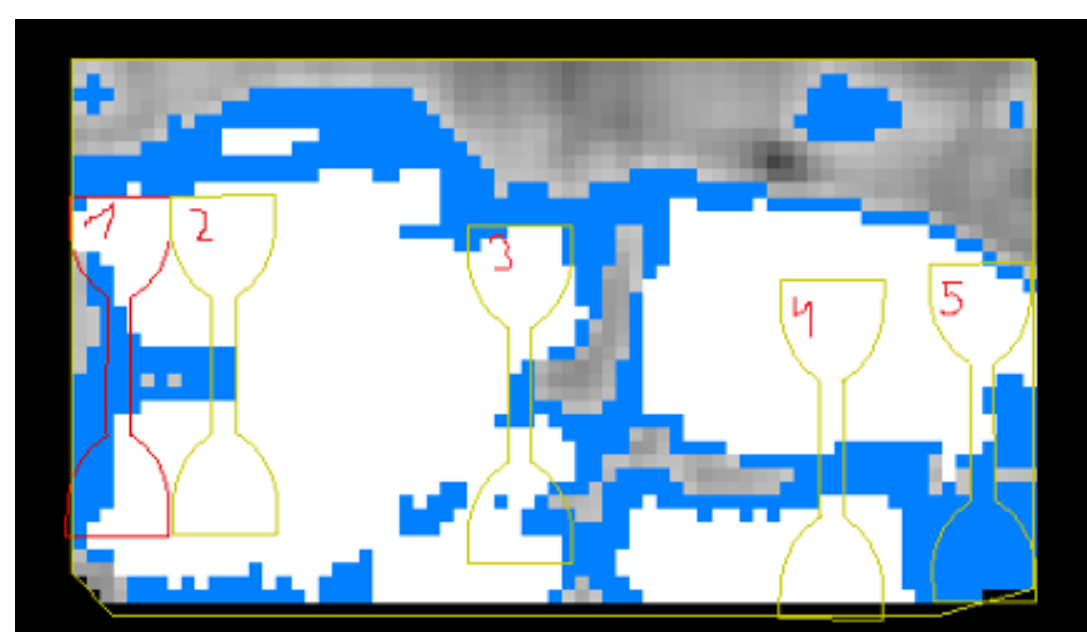
Figure 3. The image was obtained on a laser thickness gauge with markings for subsequent cutting of tissue with a laser. The white zone corresponds to a thickness of 1.0 mm, the blue zone—0.7 mm, the gray zone—0.3